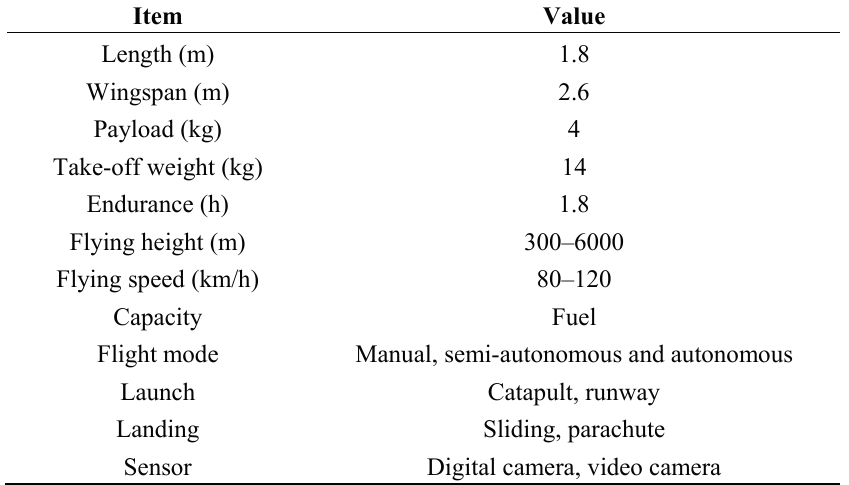
Table 1. Technical specifications of the UAV platform used in the experiment.